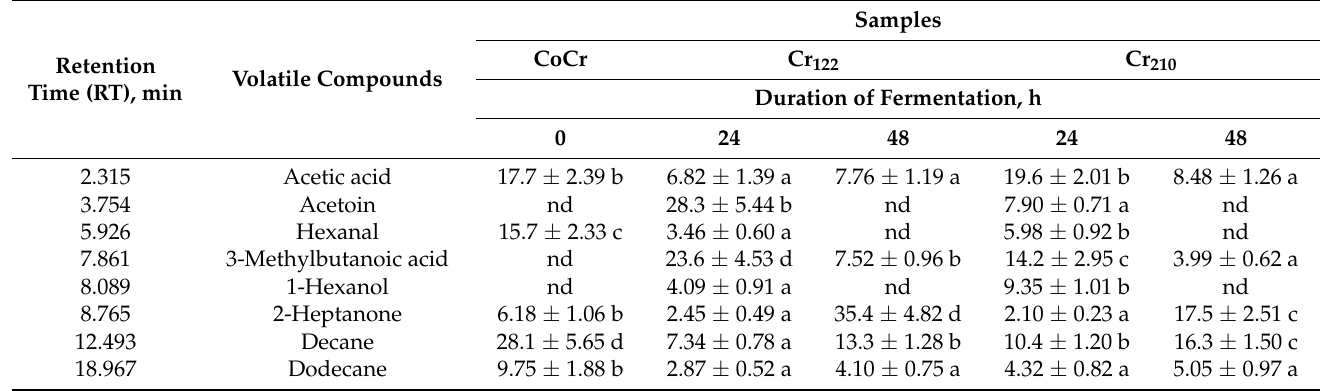
Table 4. Volatile compounds (VC) (percentage of total volatile compound content) in non-treated and fermented cricket flour